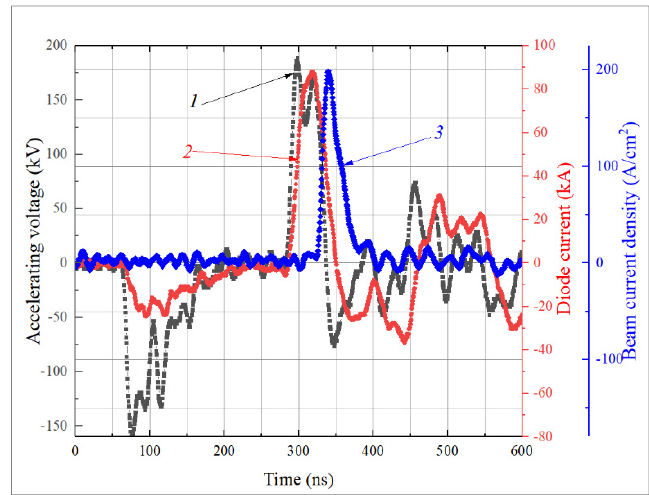
Figure 1. Oscillograms of the accelerating voltage ( 1 ), input current on the anode ( 2 ) and the intense pulsed ion beam (IPIB) current density ( 3 ) on the beam focus.